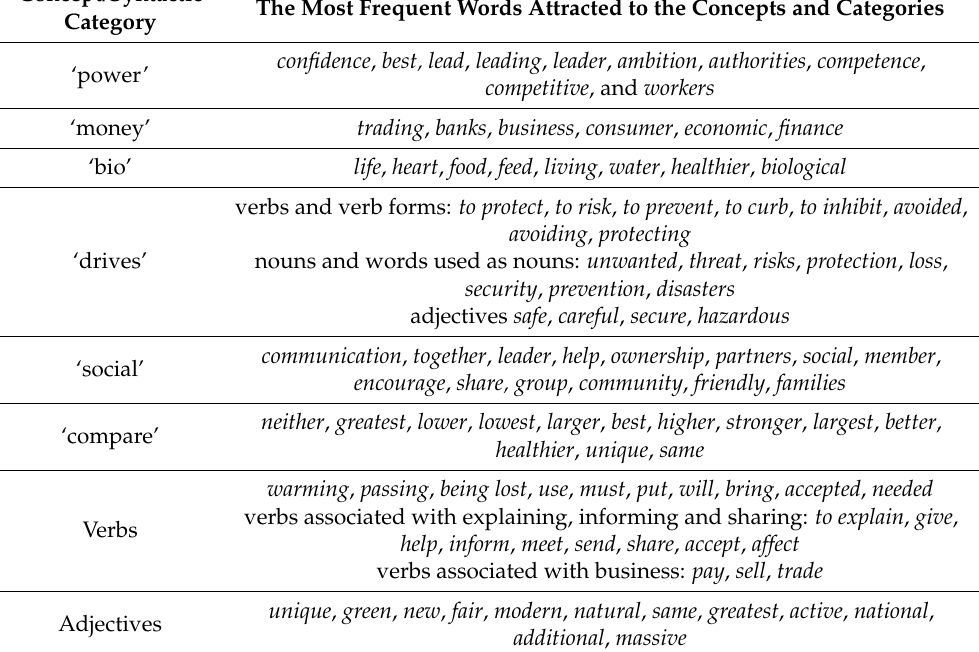
Table 1. LIWC2015 software version Macintosh v.1.6 analysis grouping words into concepts and